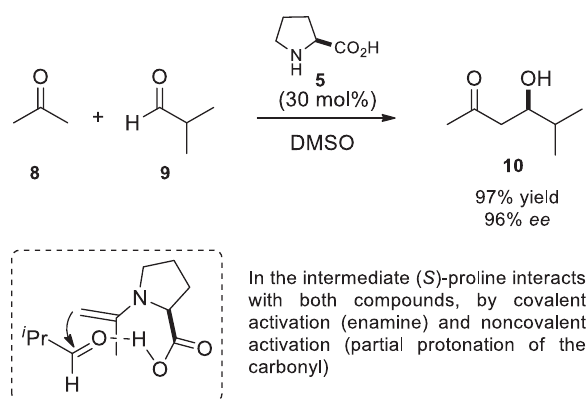
Figure 5 . Direct aldol reaction catalysed by ( S )-proline, see Ref.